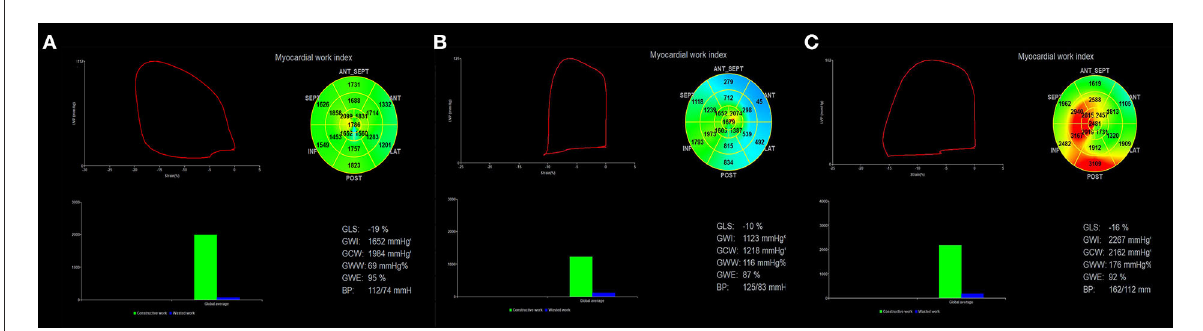
FIGURE1 Assessment of left ventricular myocardial work using NMWI. The red curve in the upper left of the figure shows the relationship between pressure and strain in the left ventricle, and its area represents GWI. The histogram at the lower left shows GCW and GWW values. The figure in the upper right shows a bullseye diagram based on the work index for 17 segments of the left ventricle. The results obtained based on the global myocardial parameters are shown at the bottom right. (A) Myocardial work results obtained in the control group show that the myocardial work distribution in each segment was consistent (uniform green). (B) HCM patients had a smaller left ventricular pressure-strain loop, and the blue area represents the decreased myocardial work. (C) The left ventricular pressure-strain loop increased in patients with H-LVH and the red color indicates the enhanced myocardial work. NMWI, non-invasive myocardial work index; GWI, global work index; GCW, global constructive work; GWW, global wasted work; GWE, global work